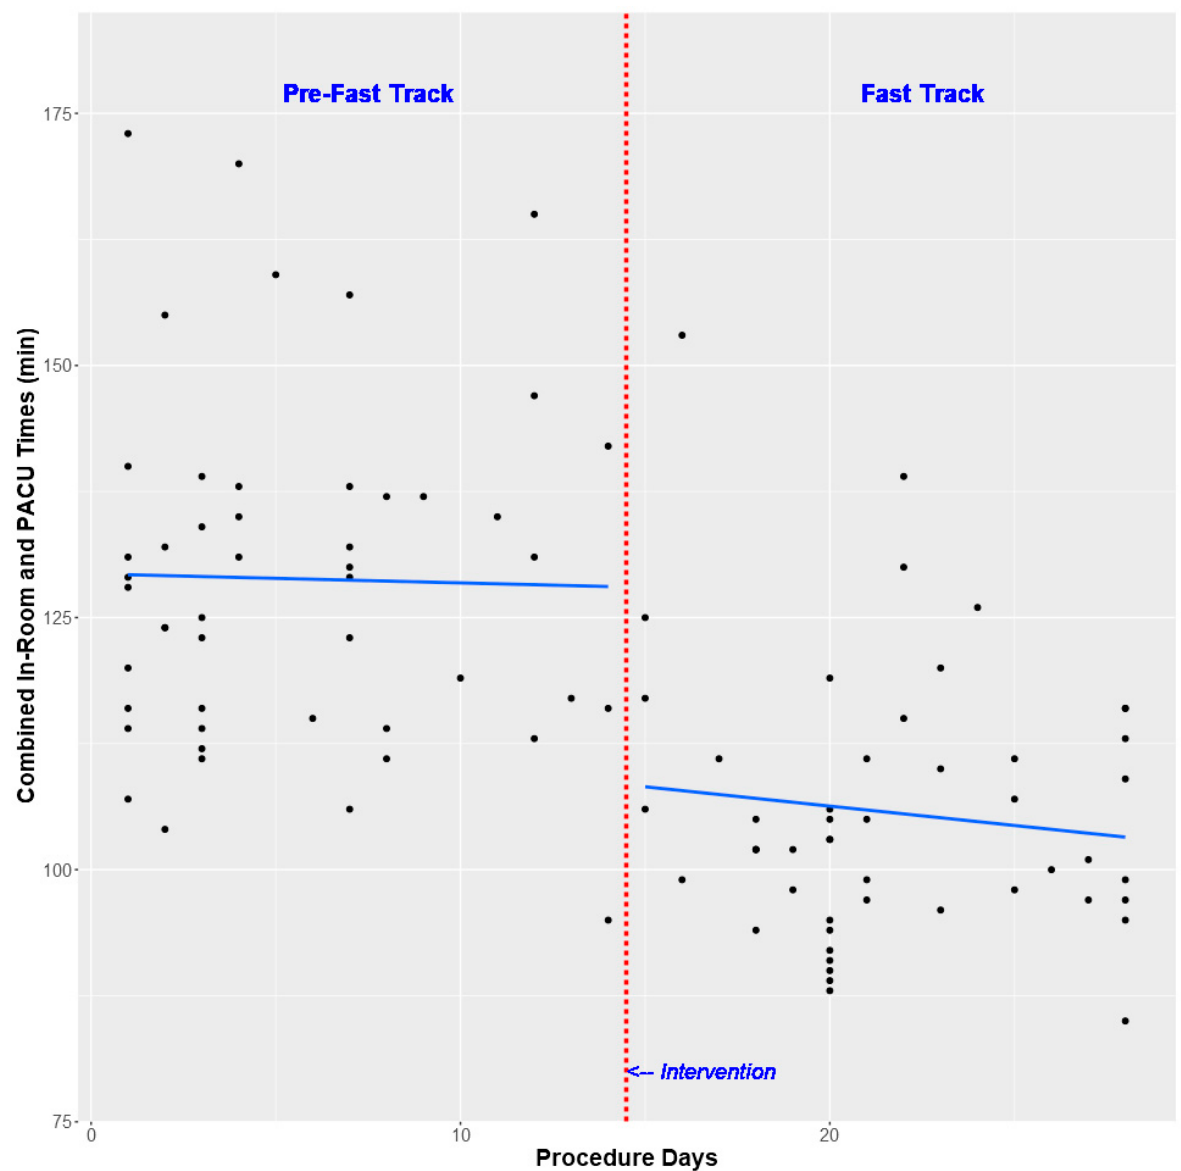
Figure 1. Scatter plot with superimposed segmented simple median regression line with break point at time of fast track implementation (procedure day 15). The Y variable is combined in-room and PACU times for each procedure while the X variable is the sequential days that circumcisions and/or circumcision revisions were performed over the entire study period. Based on this graph, there appears to be a stepped decrease in combined time that corresponds to the implementation of fast tracking. Table 4. Association between Fast Track and In-Room/PACU Time. § Unadjusted ¶ Adjusted §